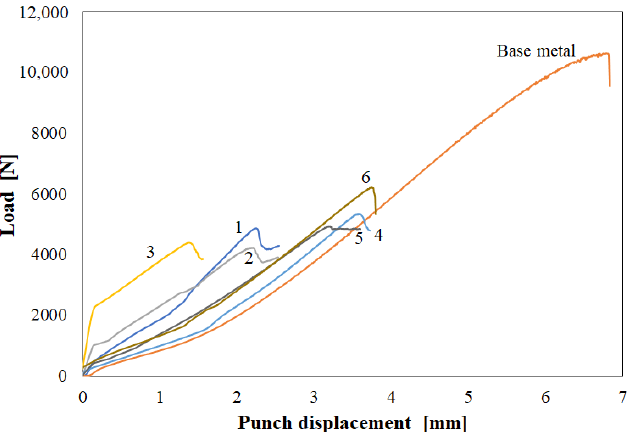
Figure 9. Load-punch displacement curves of the Erichsen cupping tests of the welded joints (the numbers in the graph refer to the experimental runs) and the 2 mm thick base metal.